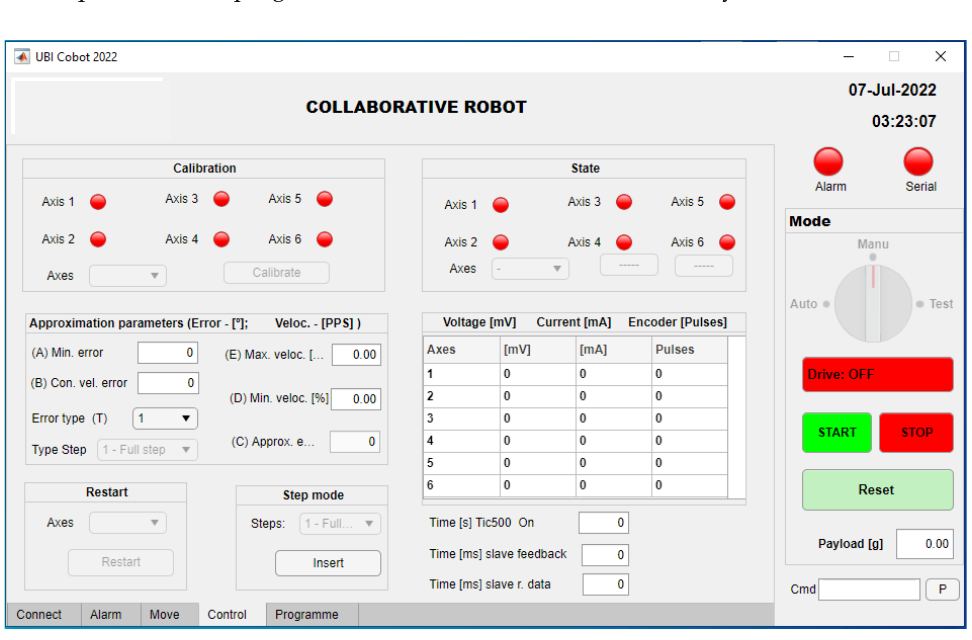
Figure 14. User interface; control menu.